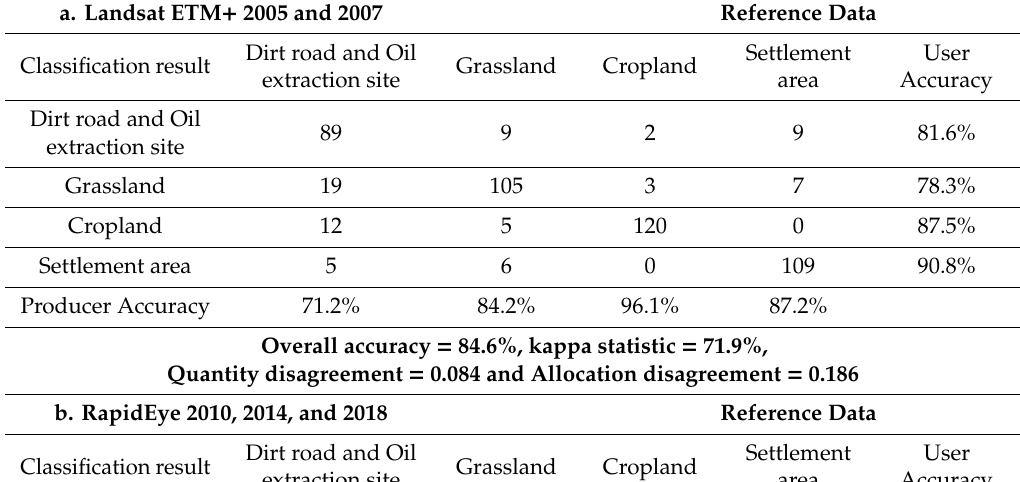
Table A1. Summary of confusion matrices for the multi-resolution and multi-spectral satellite image classification in